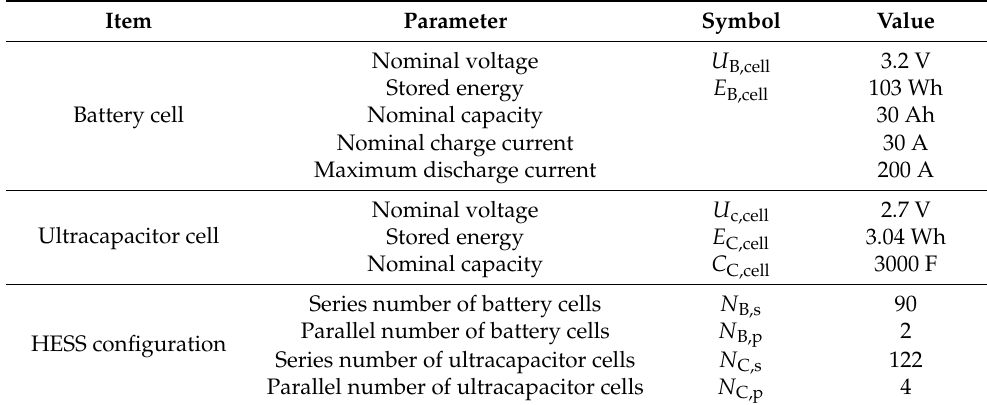
Table 1. Parameters of the